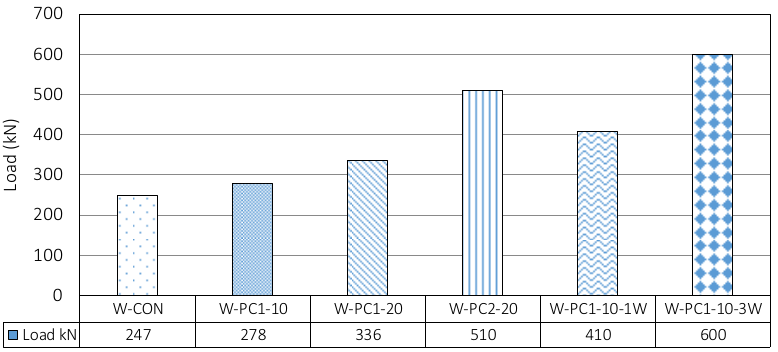
Figure 17. Load of CCIHBM walls.